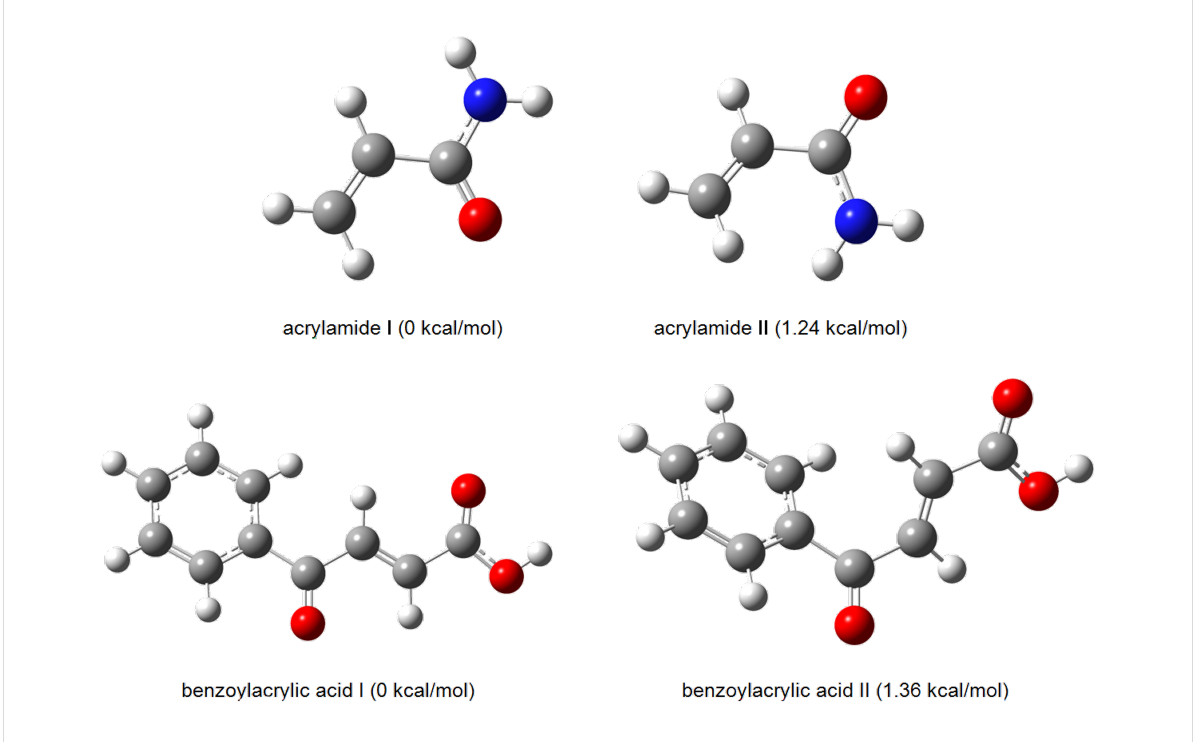
Figure 5: Conformations of acrylamide and benzoylacrylic acid.